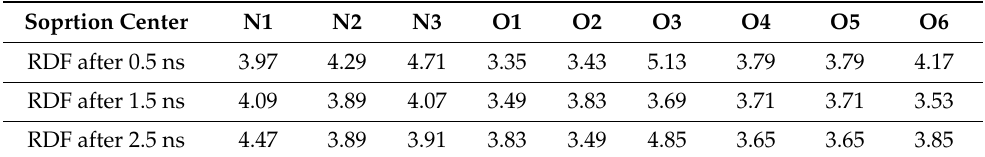
Table 4. Maximums of radial distribution functions between isopropanol and sorption centers in PBOI